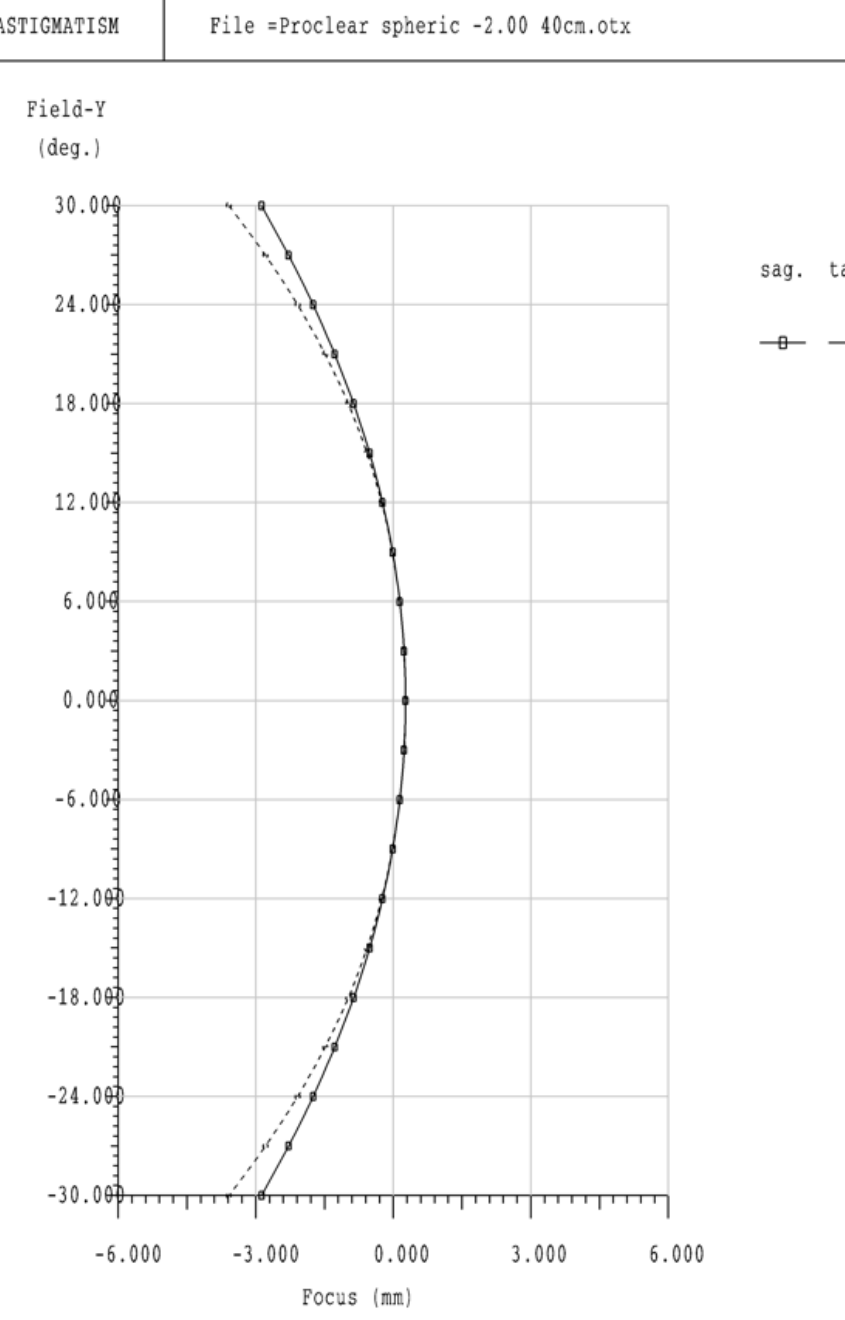
Figure 7. Peripheral refraction with Proclear monofocal correction − 2.00 D of myopia, viewing distance at 40 cm: sagittal and tangential focal lines. Within the central 18° a lag of accommodation is visible that refers to a hyperopic defocus. Outside the central 18° both focal lines become myopic relative to the center (Fovea).